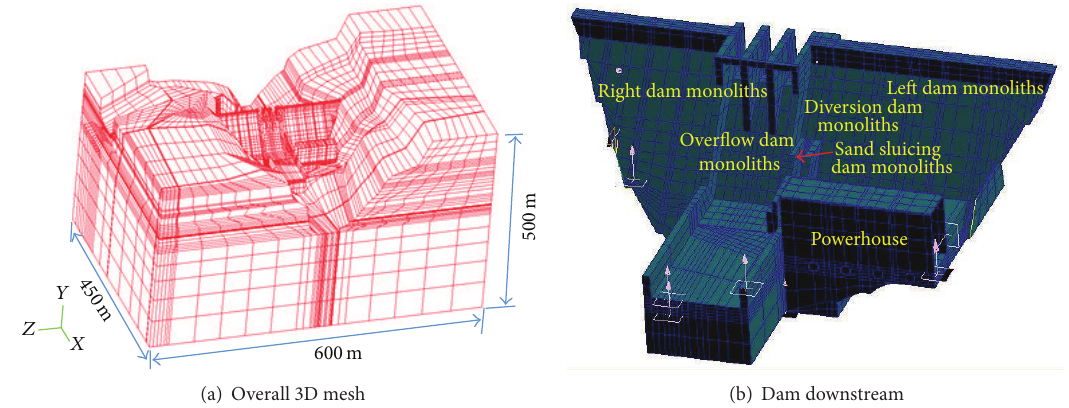
Figure 2: Schematic mesh model of Guoduo gravity